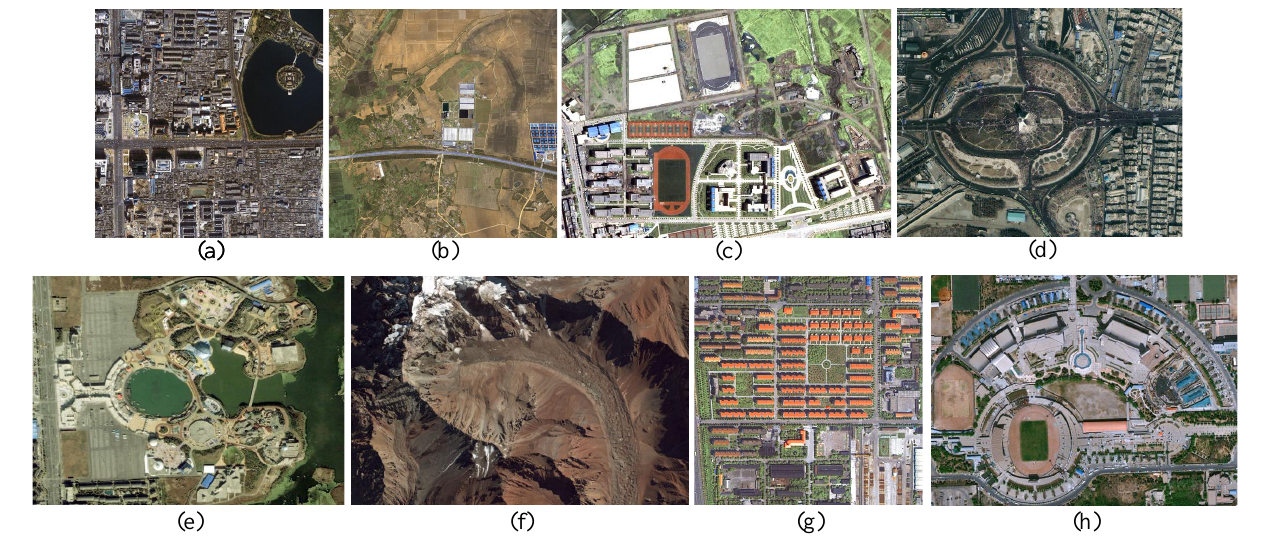
Figure 4. Display images in datasets. ( a – d ) are the IKONOS dataset’s images. ( e – h ) are the QuickBird dataset’s images. Table 2. Dataset information.